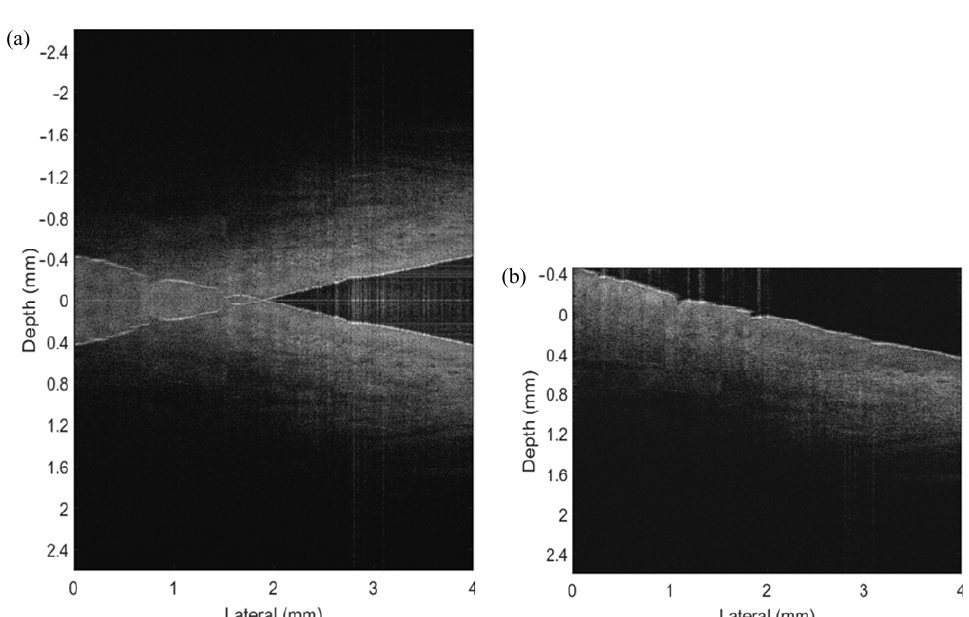
Figure 6. The experimental results of an in vivo nailfold on the index finger of a healthy volunteer’s right hand. ( a ) The conventional OCT image with conjugate artifacts, causing imaging confusion and overlapping of the negative and positive information. ( b ) The FROCT image reconstructed using a voice coil motor as a phase modulator. The FROCT image shows a larger imaging range with mirror artifacts removed efficiently.